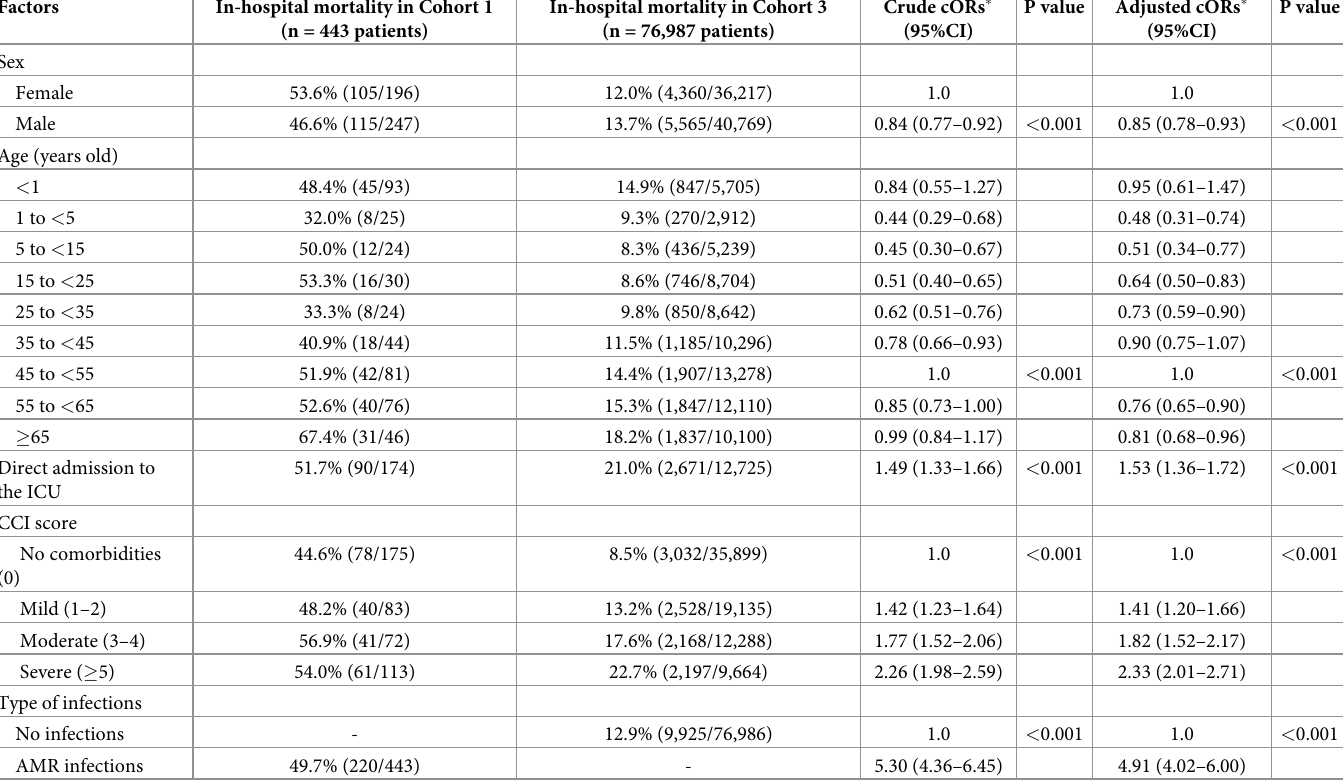
Table 3. Factors associated with in-hospital mortality in patients with AMR BSI compared with patients without a BSI with a target pathogen.